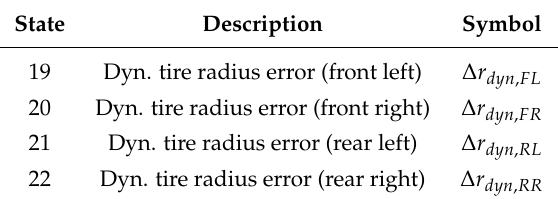
Table 4. Additional States for the Odometry Model.